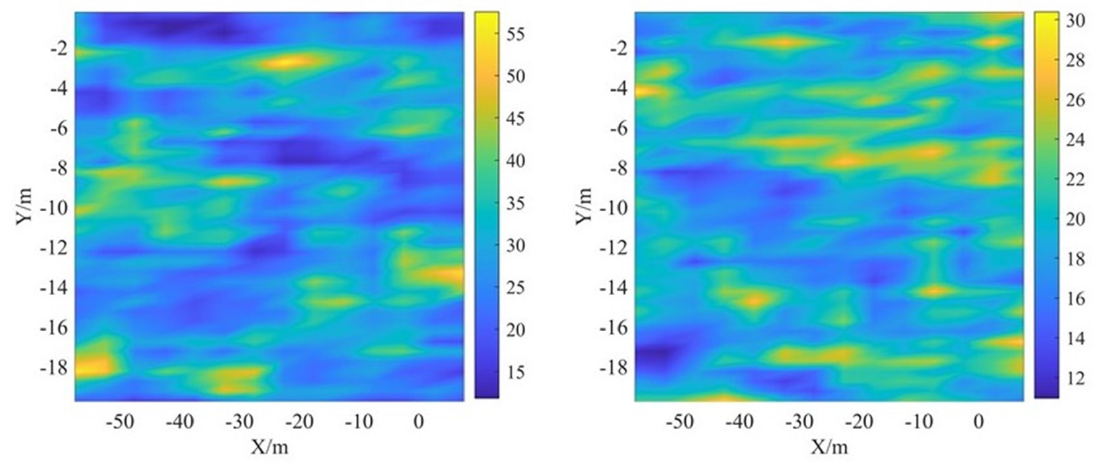
Figure 4. Random field realizations of c u ( left ) and φ ( right ) (case 3).